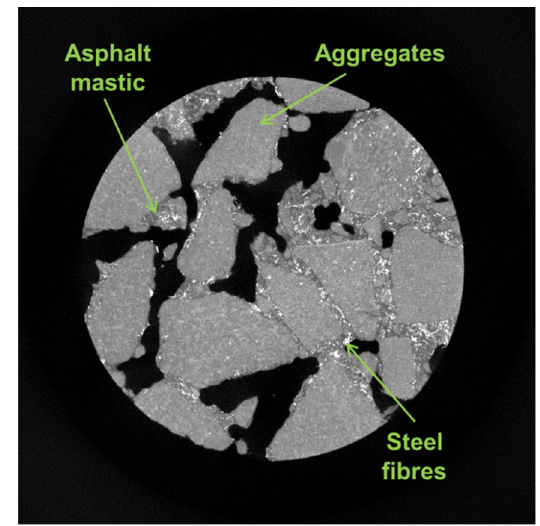
Figure 3. A top view image of CT scan on porous asphalt concrete with steel fibres.